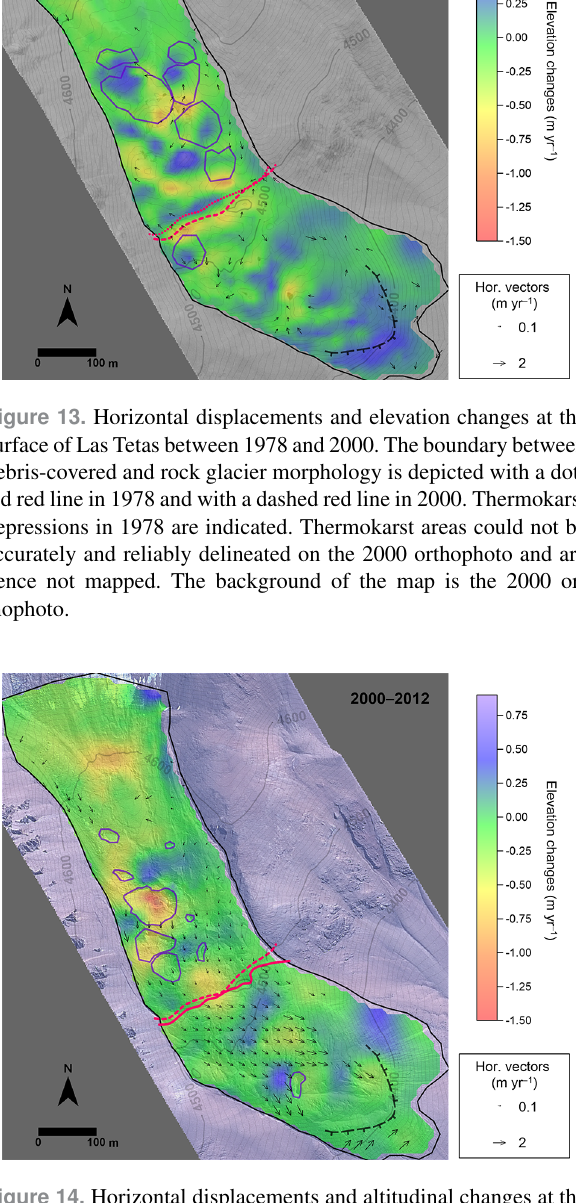
Figure 14. Horizontal displacements and altitudinal changes at the surface of Las Tetas between 2000 and 2012. The boundary be- tween debris-covered and rock glacier morphology is depicted with a dashed red line in 2000 and with a continuous red line in 2012. Note that thermokarst depressions in 2012 are indicated. The back- ground of the map is the 2012 Geoeye